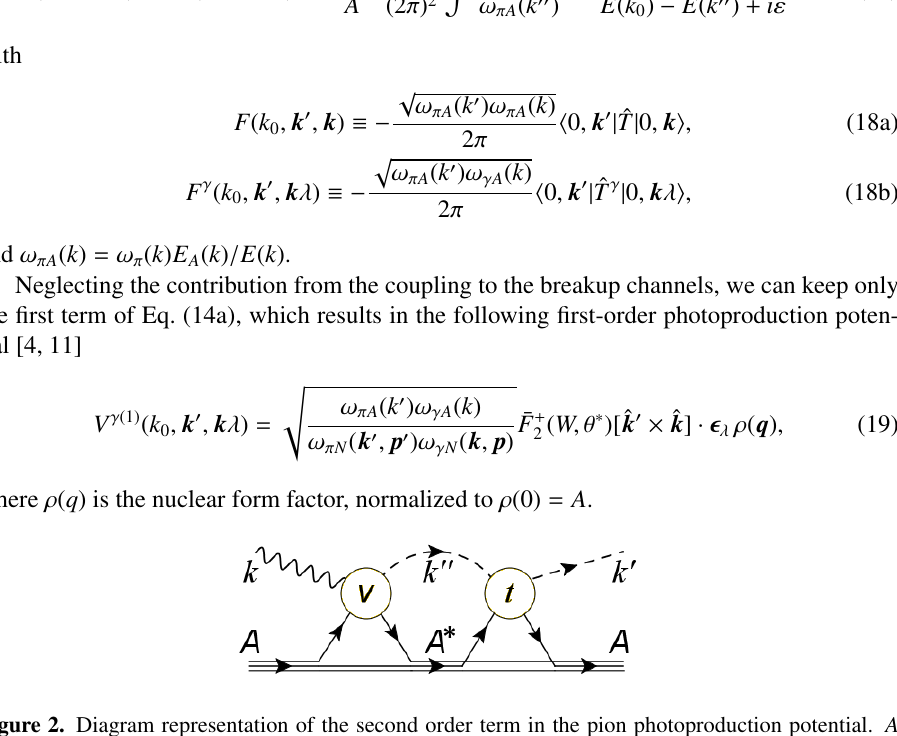
Figure 2. Diagram representation of the second order term in the pion photoproduction potential. A and A ∗ correspond to the nucleus in the ground and excited states,